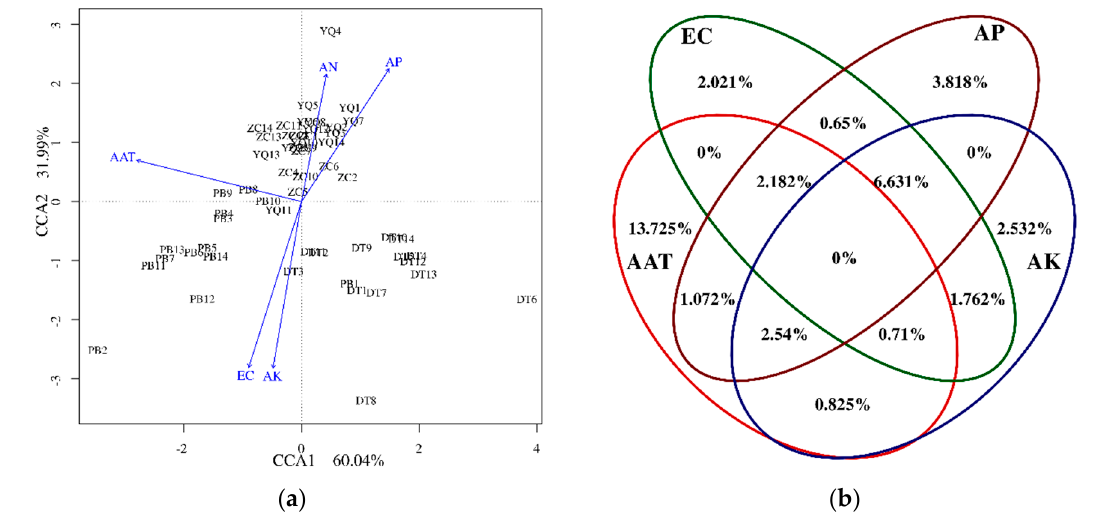
Figure 8. Correspondence analysis (CCA; ( a )) and variation partition analysis (VPA; ( b )) plots indicate the relationships between the bacterial community and soil properties.